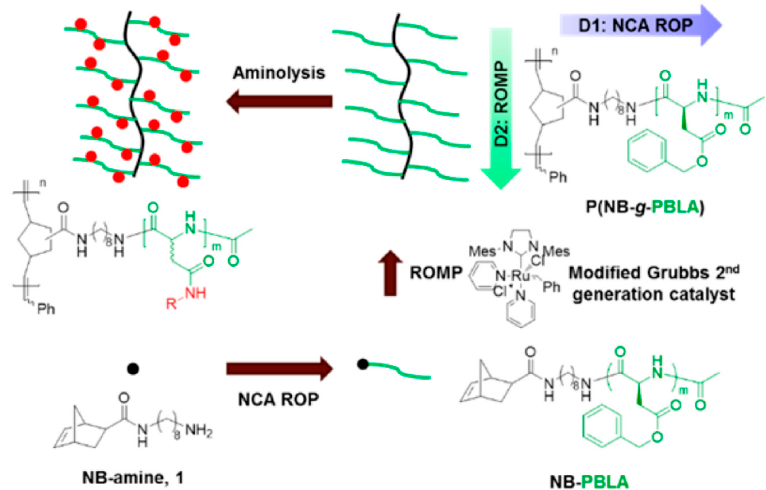
Figure 50. Synthetic design of polypeptide molecular brushes via “grafting through” strategy with postpolymerization modification using aminolysis of PBLA brush side chains. Reproduced with permission from reference [220].